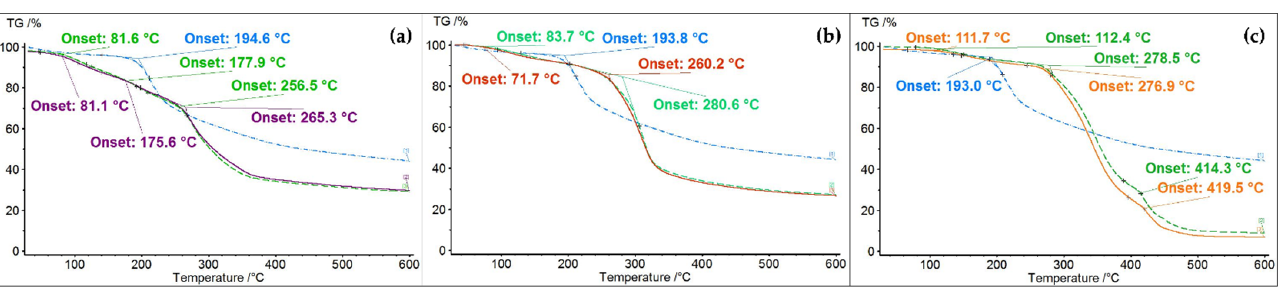
Figure 6. Thermograms of: ( a ) chitosan–cellulose–dye film (violet), chitosan–cellulose film (green), and dye (blue); ( b ) chitosan–starch–dye film (green), chitosan–starch film (red), and dye (blue); ( c ) chitosan–PVA–dye film (green), chitosan–PVA film (orange), and dye (blue). The mass losses of all obtained polymeric blends that occurred in different temperature ranges are presented in the Supplementary Materials, Tables